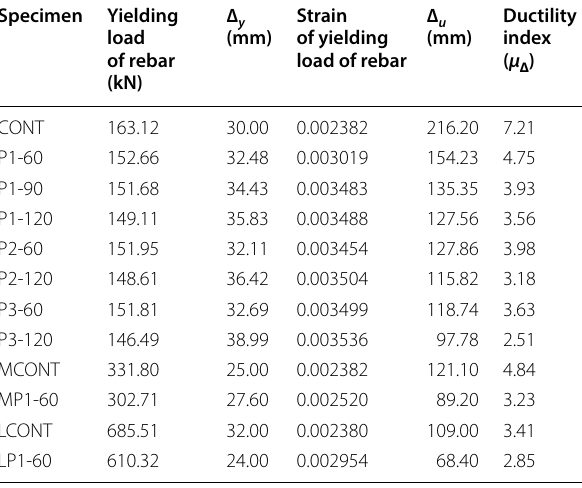
Table 6 Deflection ductility index of beams. Specimen Yielding